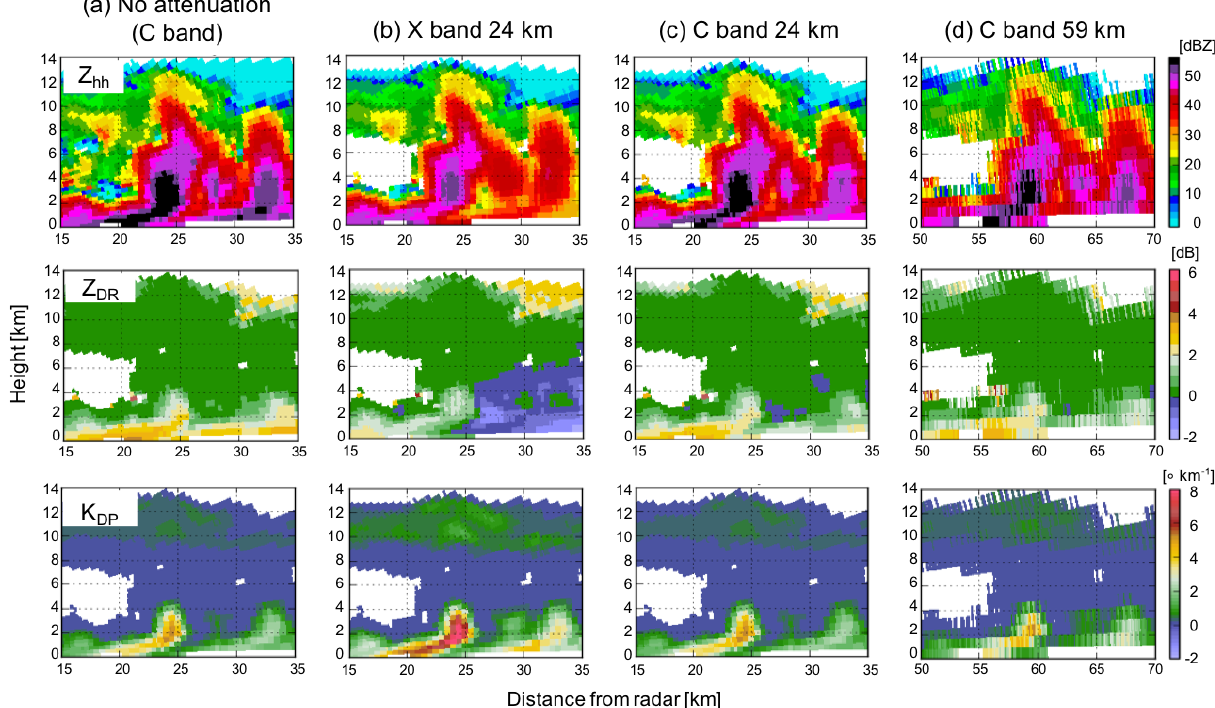
Figure 4. Examples of C- and X-band (5.5 and 9GHz, respectively) RHI scans with a beamwidth of 1 ◦ produced using CR-SIM for a convective cell in a mesoscale convective system (MCS). The simulation uses WRF with the Morrison 2-moment microphysics scheme for an MCS on 20 May 2011 during MC3E. Shown are variables at X- and C-band frequencies 15–35km from the radar as a function of height at 12:18:00UTC: (top raw) Z hh , (middle raw) Z DR , and (bottom raw) K DP . The figure shows (a) C-band variables without attenuation, (b) X-band variables with attenuation from a radar 24km from the convective cell, (c) C-band variables with attenuation from a radar 24km away, and (d) C-band variables from a radar located 59km away with